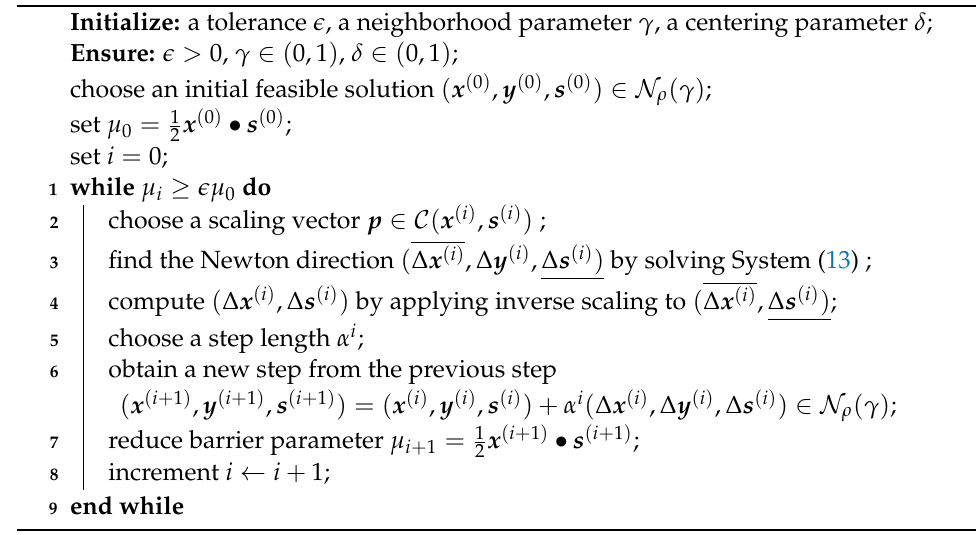
Algorithm 1: A path-following interior algorithm for solving RQCP